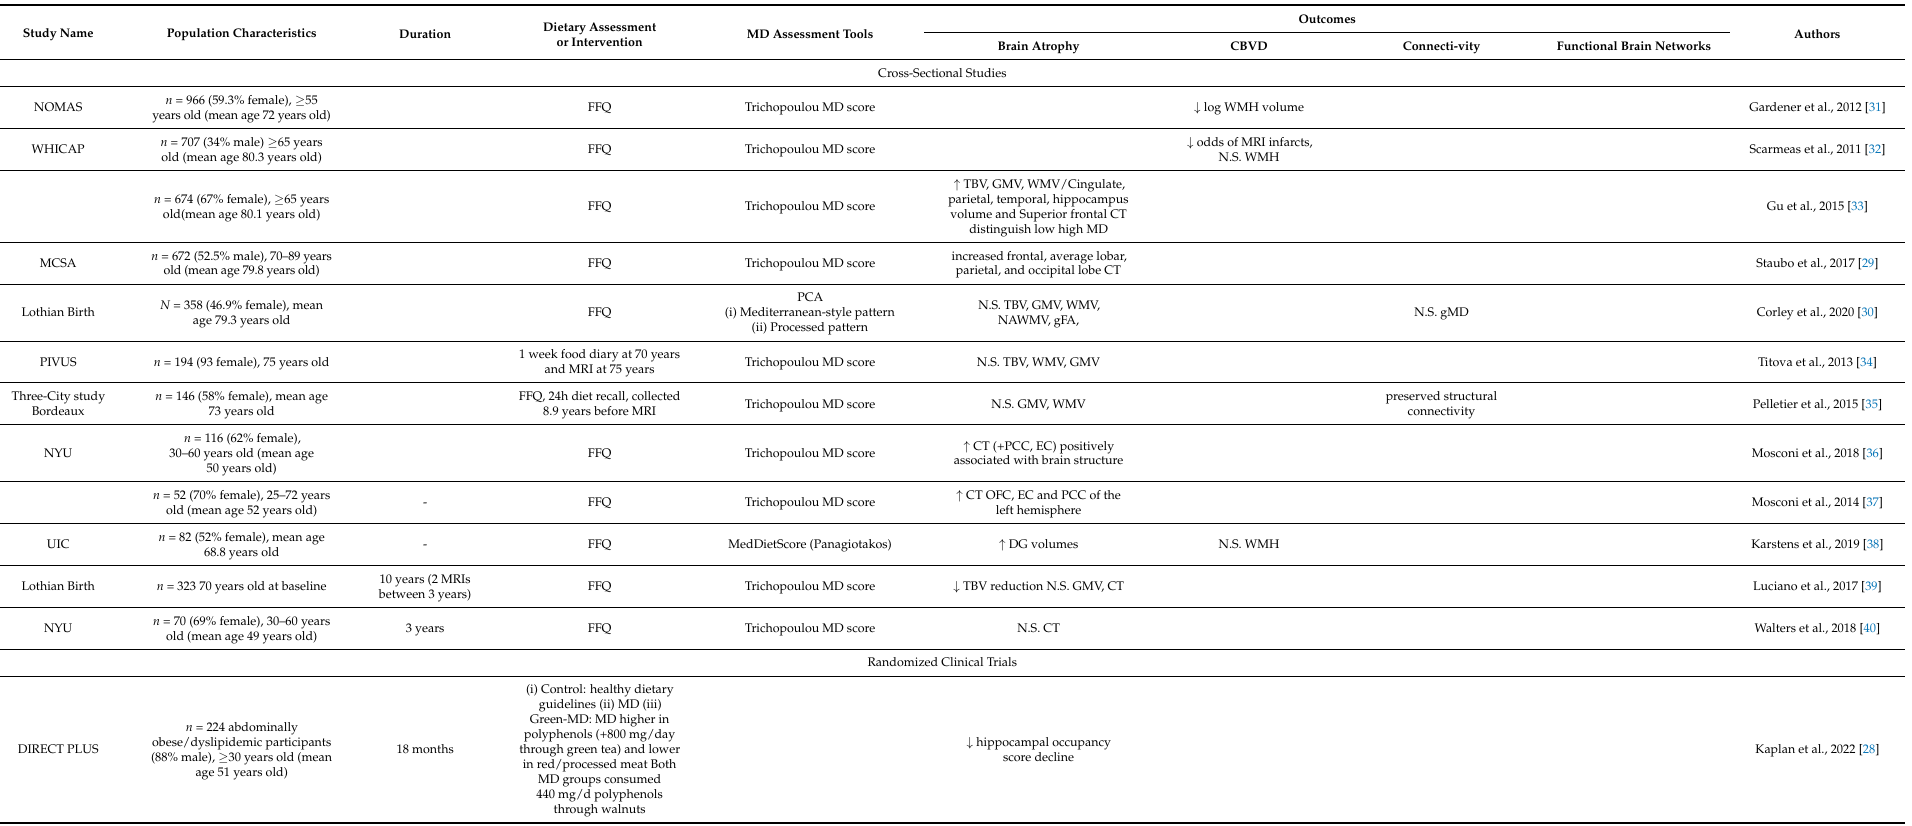
Table 1. Studies examining the association between higher adherence to the Mediterranean diet and brain MRI biomarkers in adults without